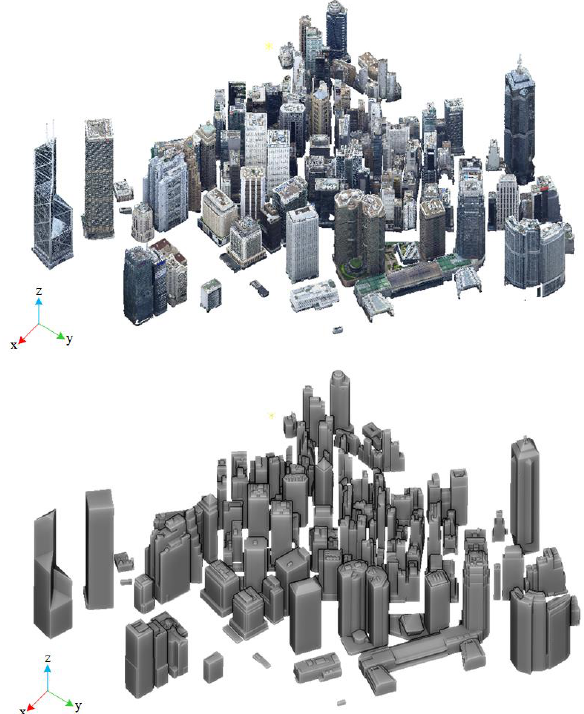
Figure 7. Overview of the textured point clouds (first row) and the reconstruction results (second row) of the 105 buildings in Central, Hong Kong.